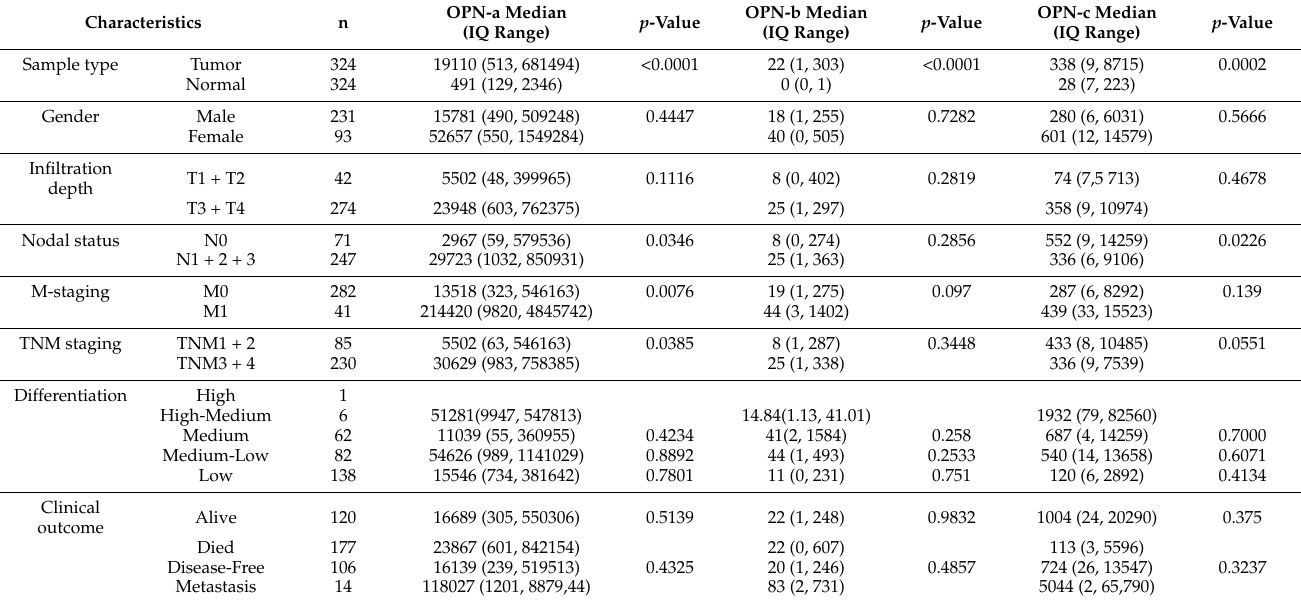
Table 2. The expression of OPN splice variants in tissue from gastric cancer patients. Analysis was performed by Mann– Whitney U test and results were considered statistically significant if p < 0.05.